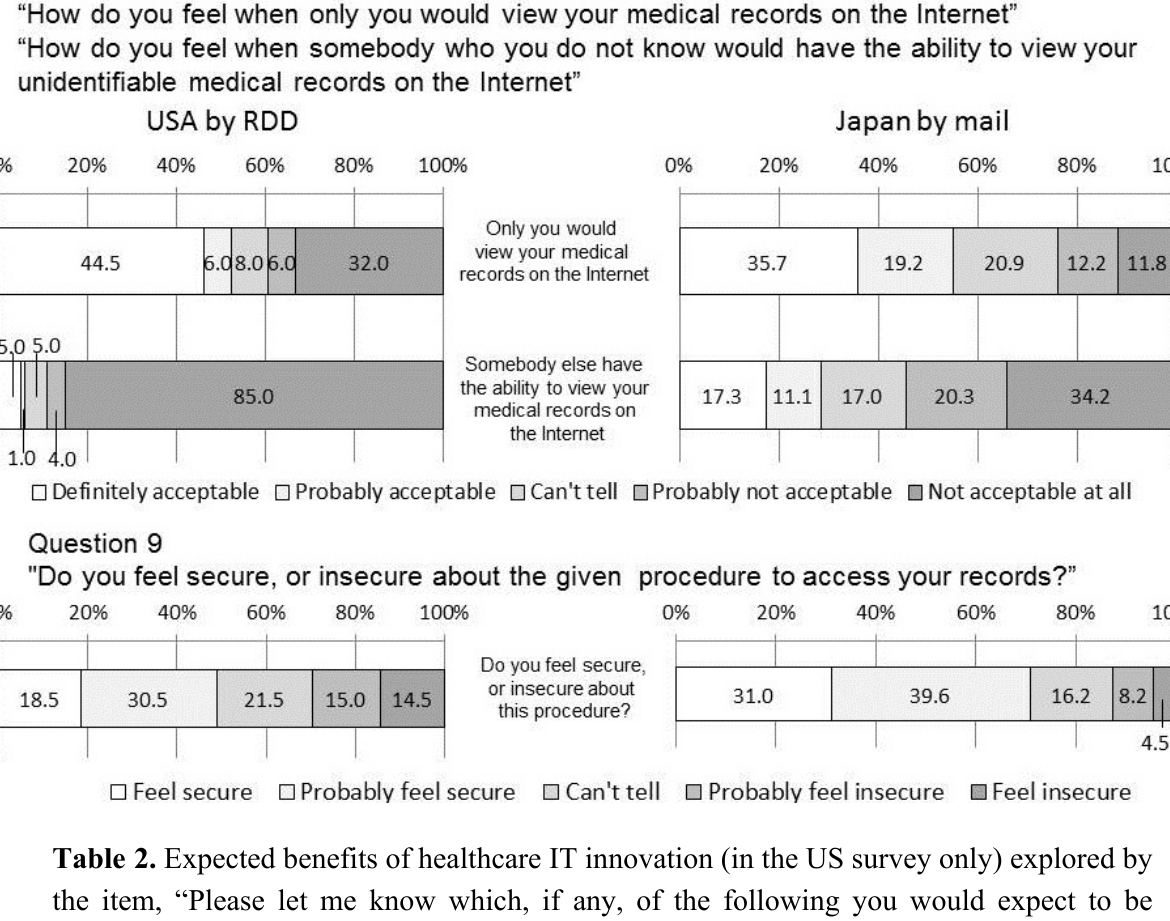
Figure 5. Findings related to access to medical records on the